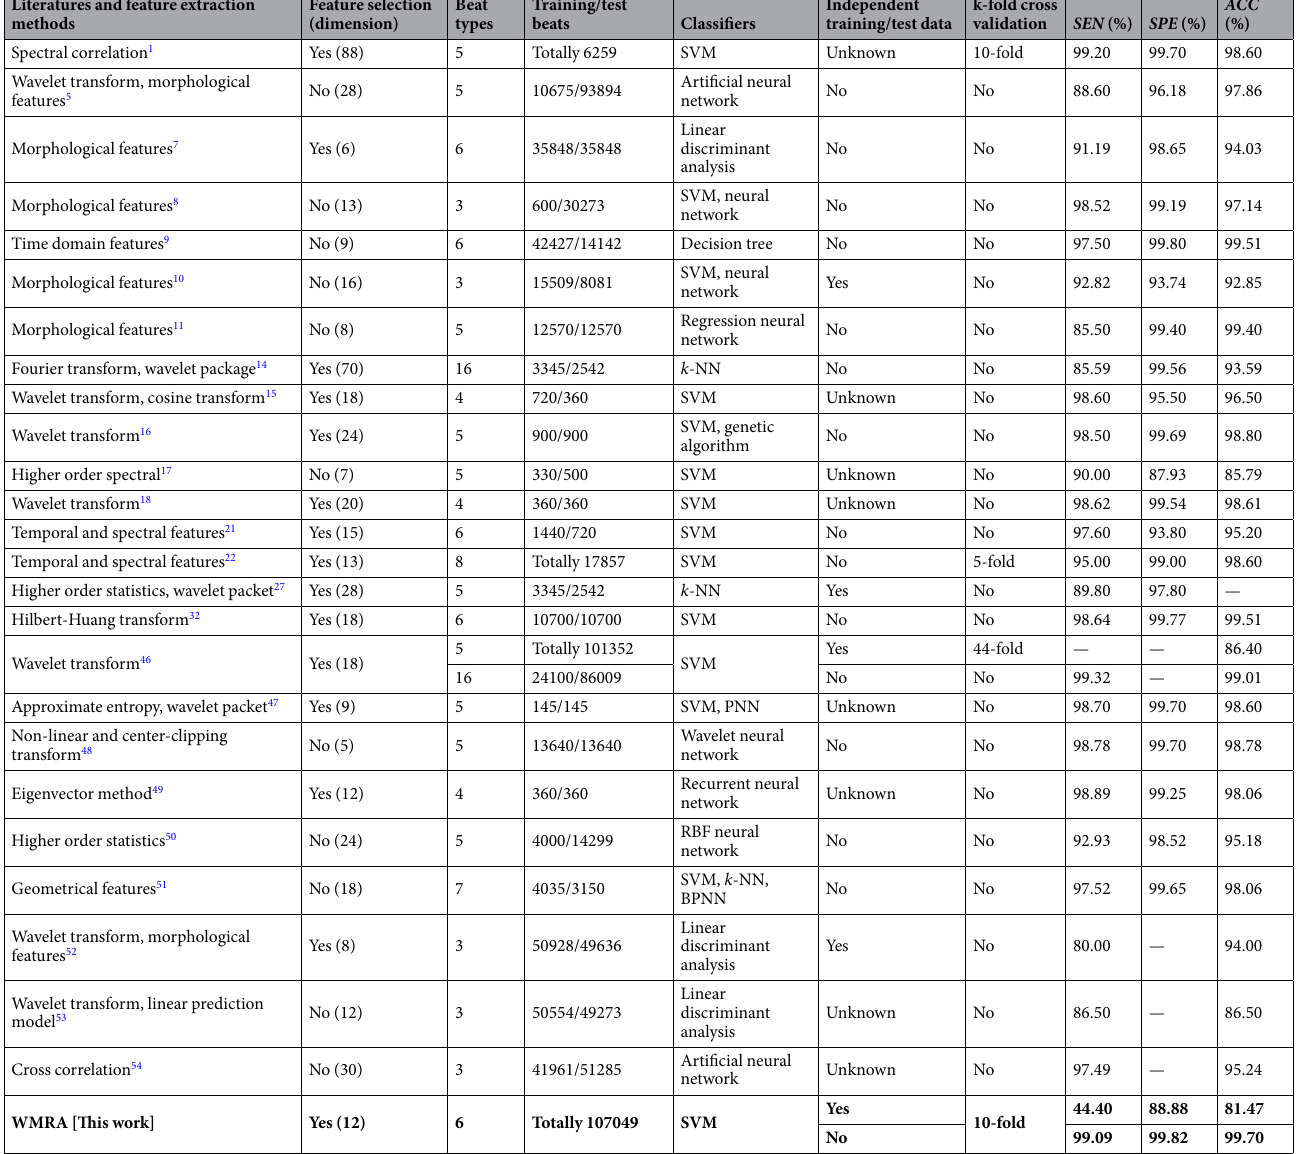
Table 6. Comparison between the related works and the method proposed in this